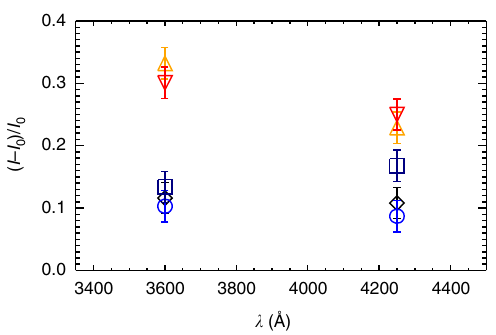
Fig. 4 Maximum continuum contrasts at the white-light kernels. The data are measured for the fi ve kernels and the two wavebands (3600 and 4250 Å). The colors of the symbols correspond to the colors of the arrows in Fig. 1b. The vertical bars represent an observation error of 2.5% at both